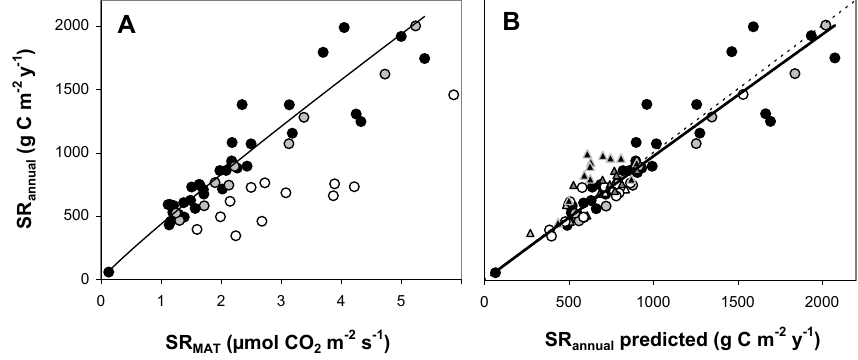
● season occurs (closed circles: ) (SR annual = 436.2 SR MAT 0.926 , R 2 = 0.94, p < 0.001). Shaded ● and open circles indicate seasonally dry sites where SR was based on annual ( ) and wet MAT